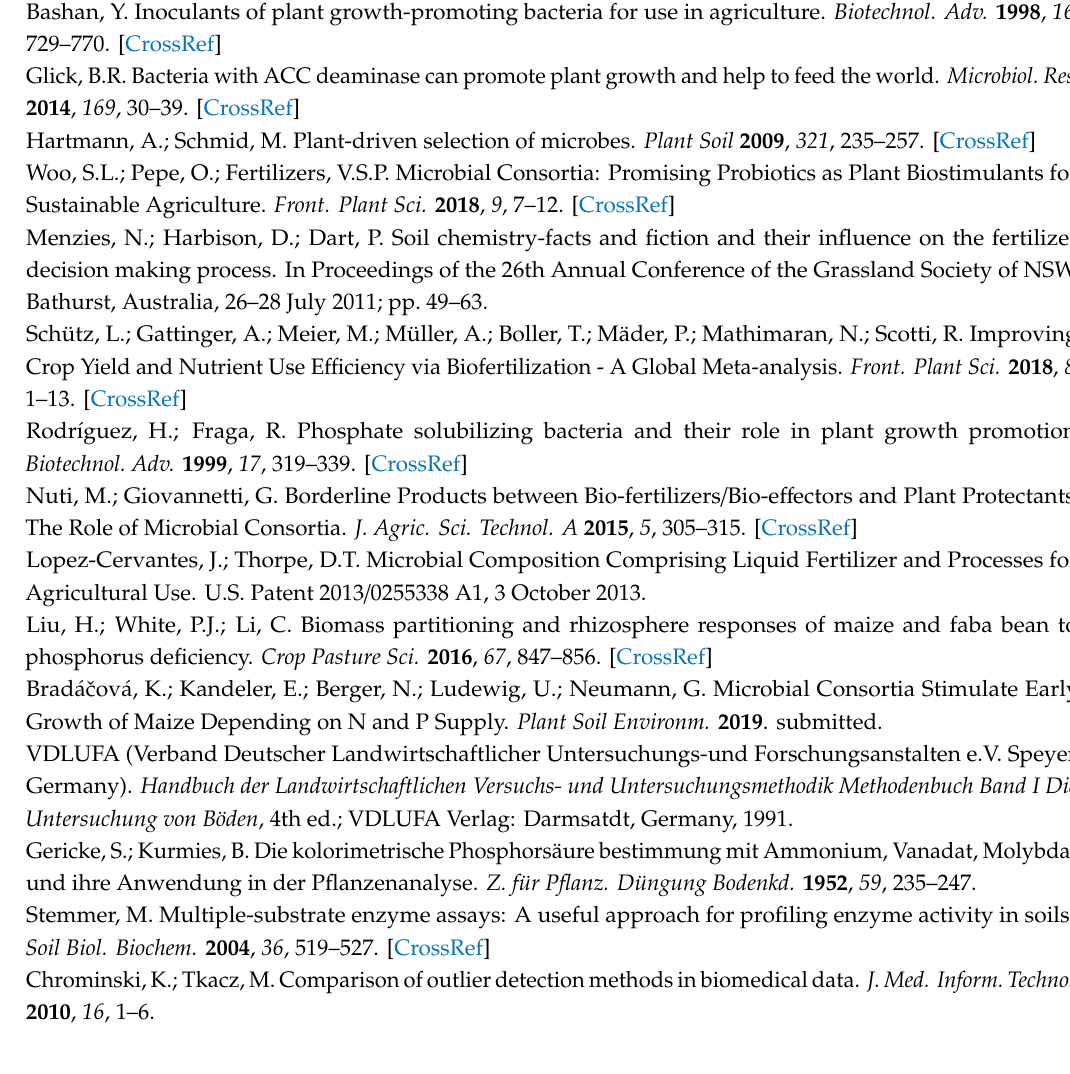
Table S1: Physical and chemical soil properties of three di ff erent experimental